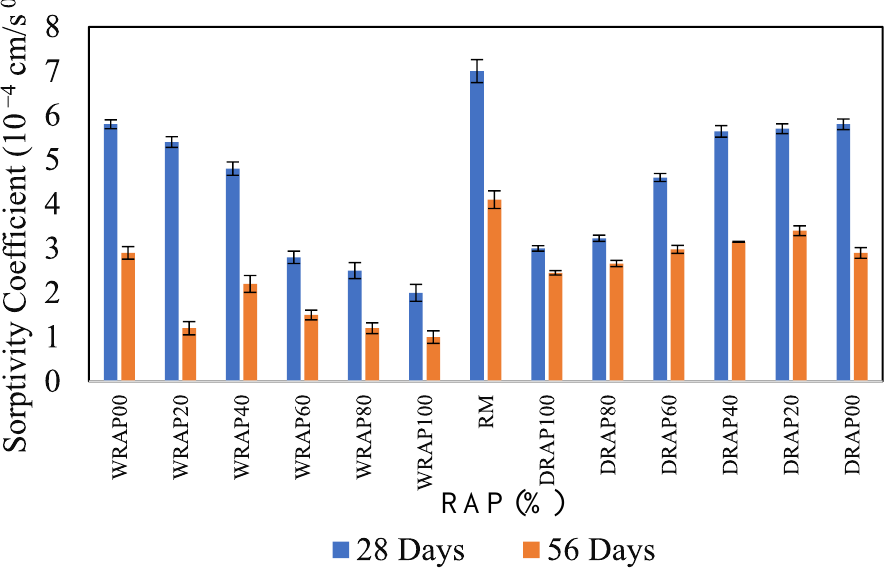
Figure 9. Variations of sorptivity coefficient on RAP concrete mixes.